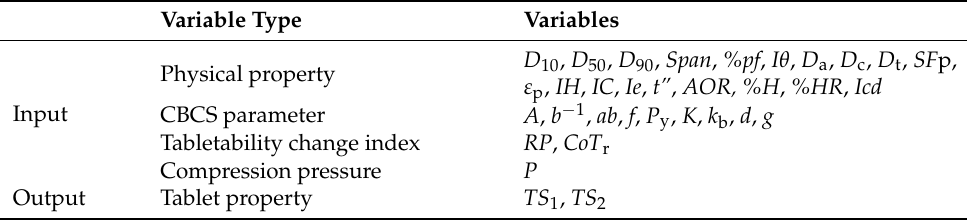
Table 4. Description of input and output variables for the partial least squares (PLS2)